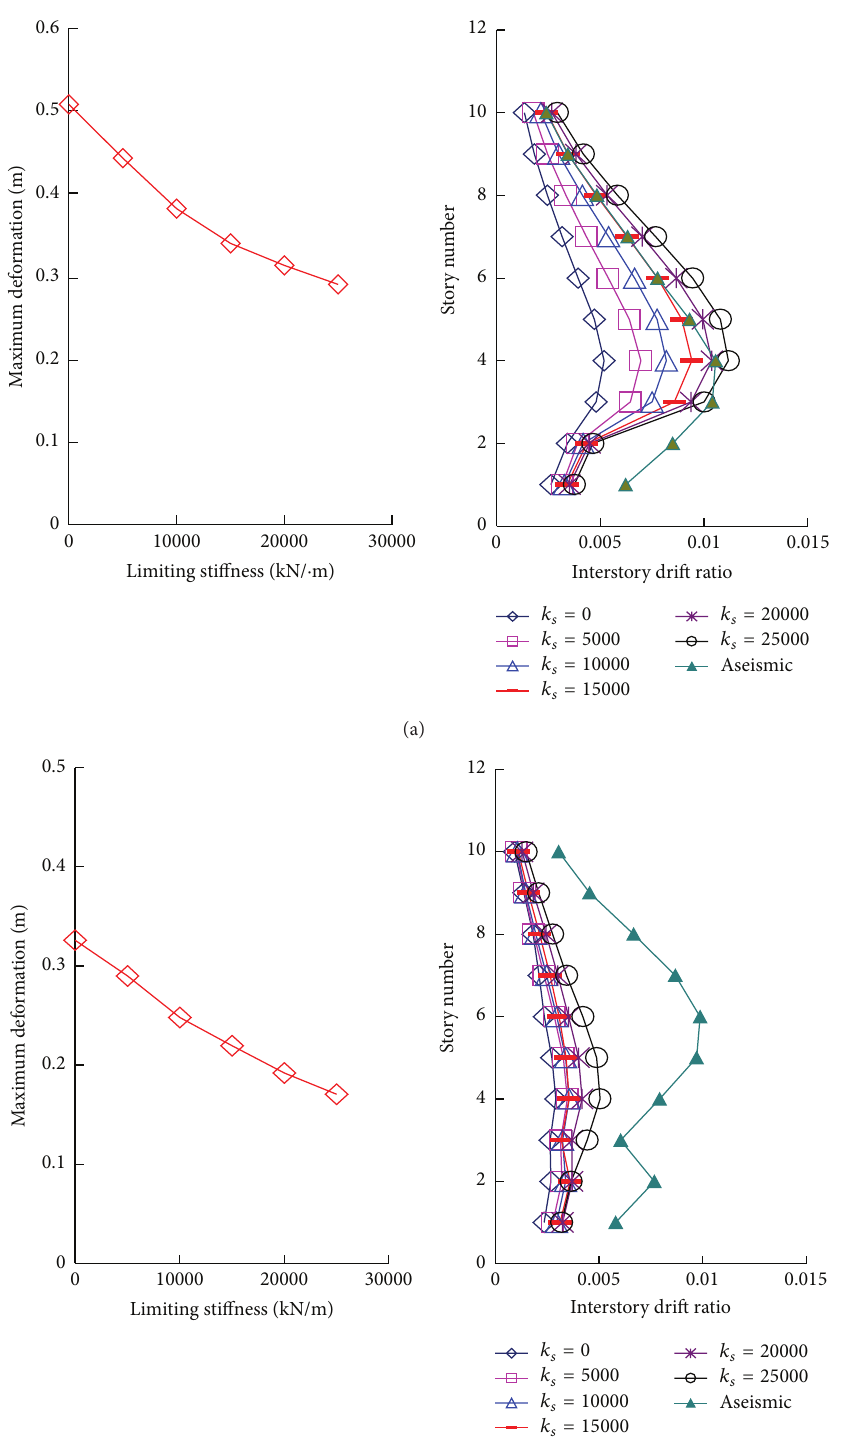
Figure 12: Effect of limiting stiffness on response of midstory isolated structure under different earthquake waves. (a) HE04230; (b)